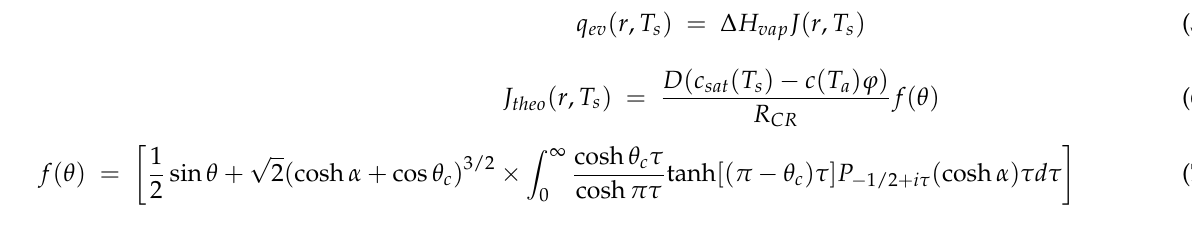
transfer through the transverse direction of the droplet due to the heat transfer through the transverse direction of the multi-layer.